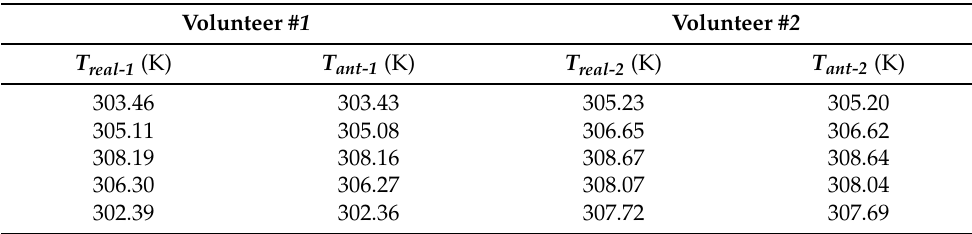
Table 8. The temperatures obtained from the simulation of the radiometer using the temperatures patterns of the